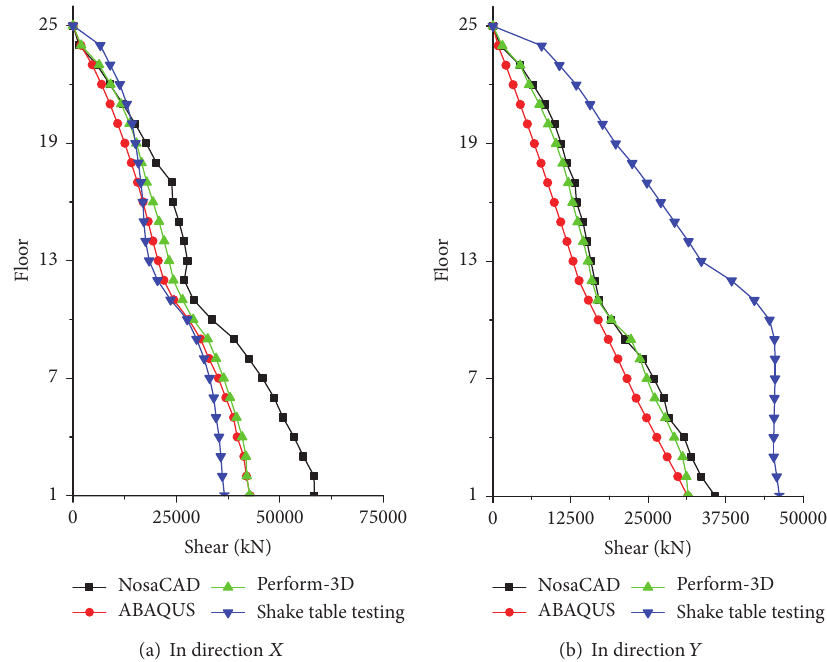
Figure 22: Story shear envelopes under rare intensity 7 earthquakes.